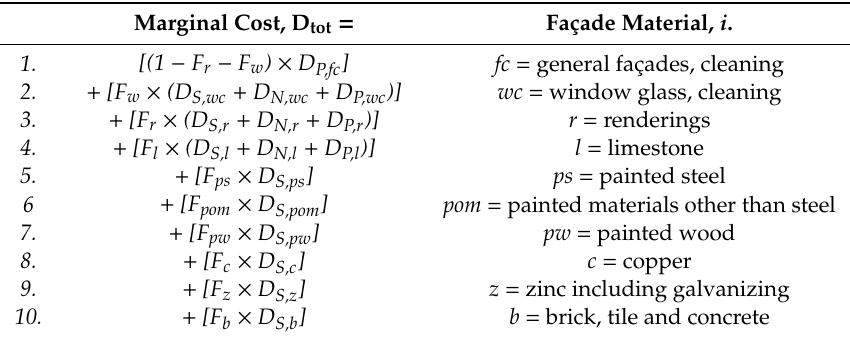
Table 1. Equations, broken up in 10